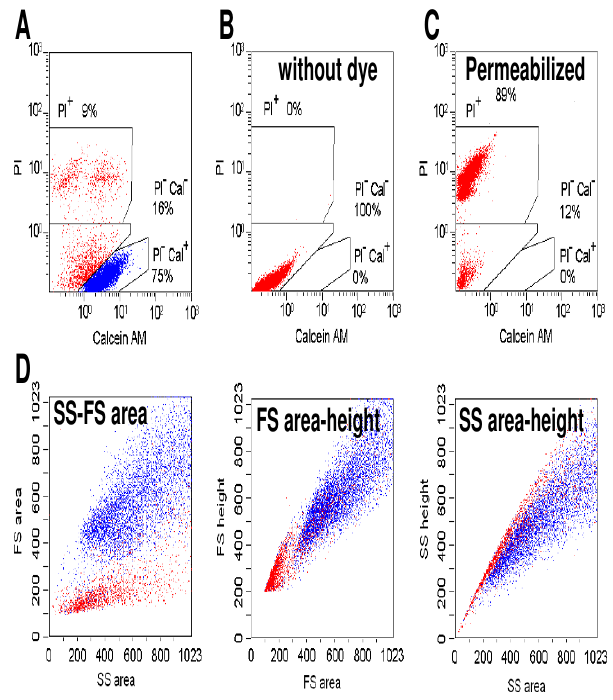
Figure 1 Living and dead cell fractions . A and D: two-dimensional profiles of the PC12 cells stained with calcein AM and PI. Cal- cein-PI ( A ) and SSarea-FSarea ( D , left), FSarea-FSheight ( D , middle) and SSarea-SSheight ( D , right). Cells without dye ( B ) and cells permeabilized by 0.1 % saponin with dye added ( C ) were used to define the dead cells. Calcein-positive and PI- negative cells (living cells) are represented by blue dots and calcein-negative or PI-positive cells (dead cells) are repre- sented by red